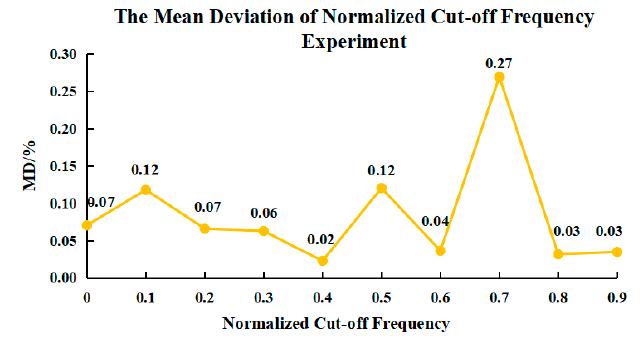
Figure 13. MD of the results for various normalized cut-off frequencies.